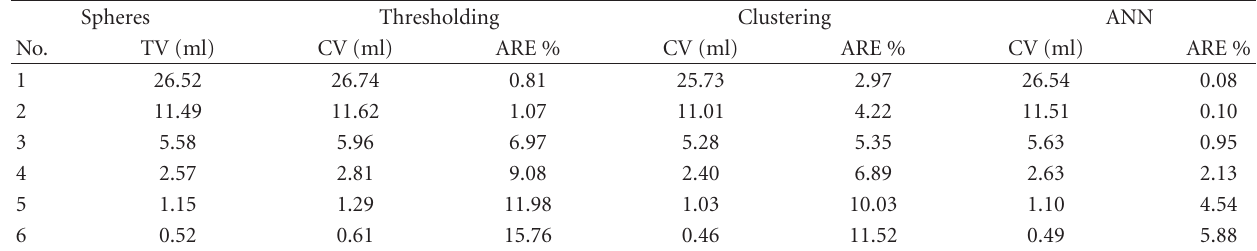
Table 3: Comparison of sphere volumes and ARE between TV and CV for di ff erent segmentation algorithms assessed including thresholding, clustering and